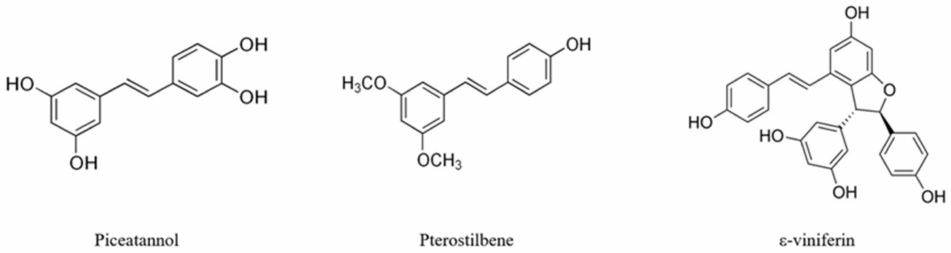
Figure 1. Chemical structures of piceatannol, pterostilbene, and ε